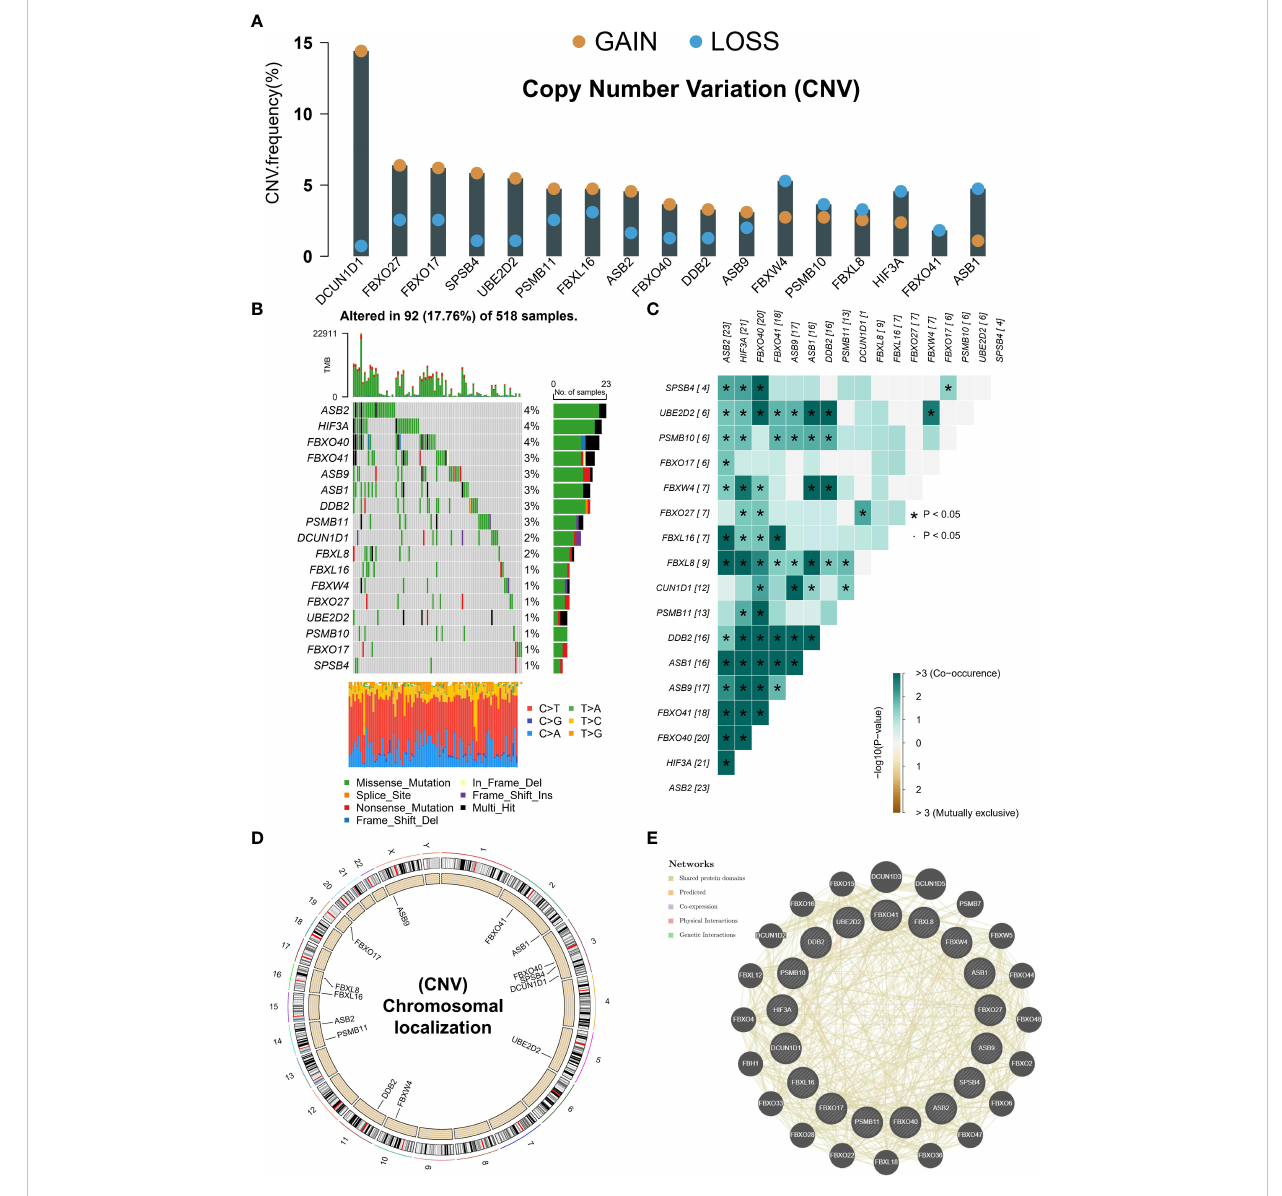
FIGURE 2 Genetic variants in prognostic NRGs. (A) CNV in prognostic NRGs. (B) Mutation landscape of prognostic NRGs. (C) Co-mutation landscape of prognostic NRGs. (D) The location of a prognostic gene on chromosome. (E) PPI network of prognostic NRGs in GeneMANIA database. *p <